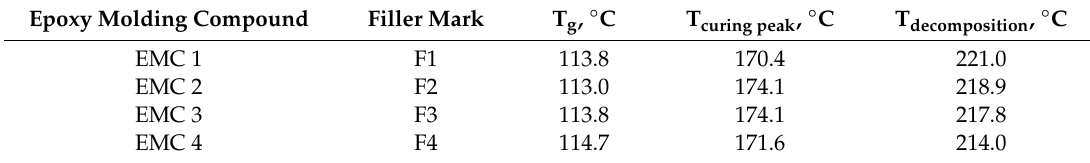
Table 2. Temperature results of DSC thermogrames for prepared EMCs.